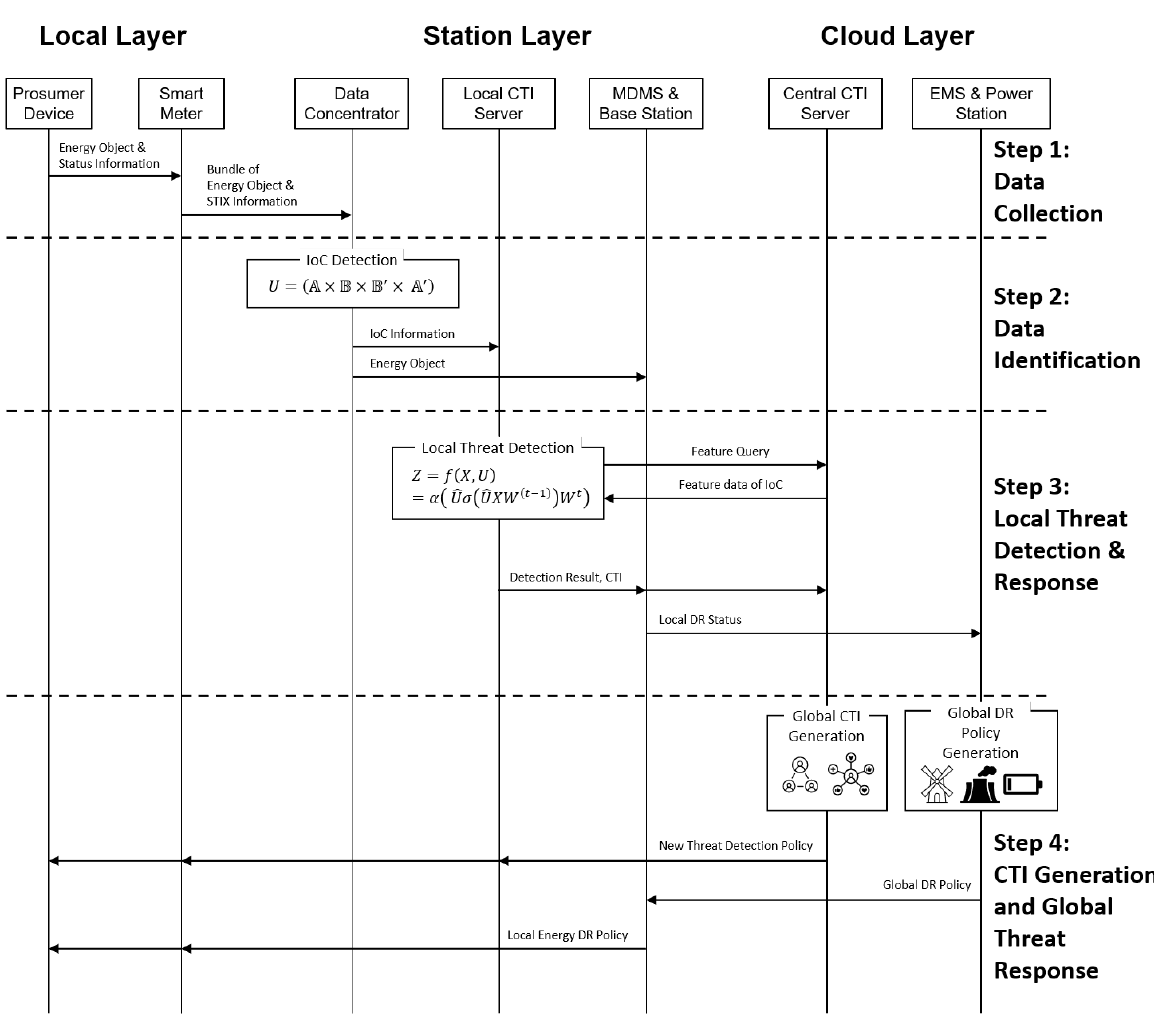
Figure 2. The dissemination process of policies on energy demand-response and CTI-based threat response in an energy cloud